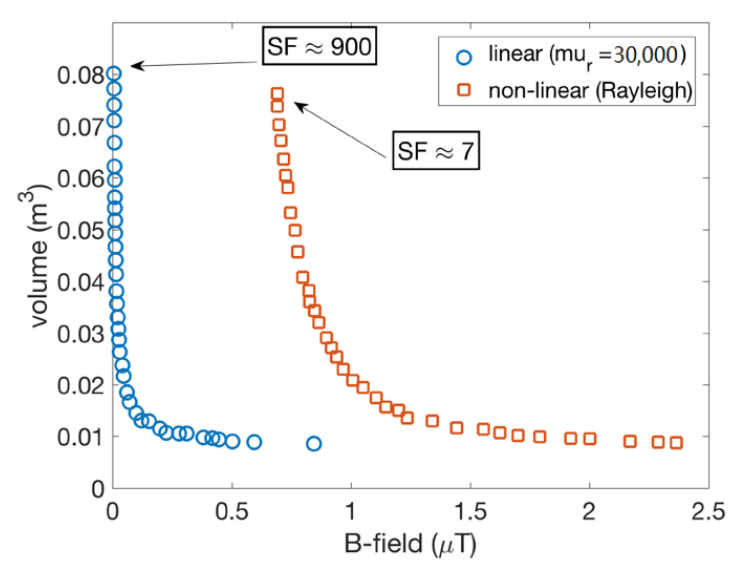
Figure 9. Comparison of the Pareto front obtained from linear and nonlinear assumption. The shielding factors computed at the B min points of each Pareto front are